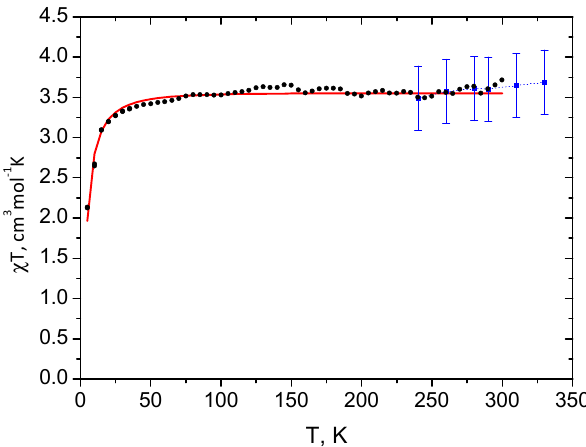
Figure 1. Variable-temperature magnetic susceptibility data for a microcrystalline sample of Fe( L1 ) 2 OTf 2 according to the dc -magnetometry ( ● ) and for its acetonitrile-d 3 solution according to the Evans method ( ■ ); for Fe( L2 ) 2 OTf 2 and Fe( L2 ) 2 (BF 4 ) 2 , see Figure S1. The red line represents the fit.